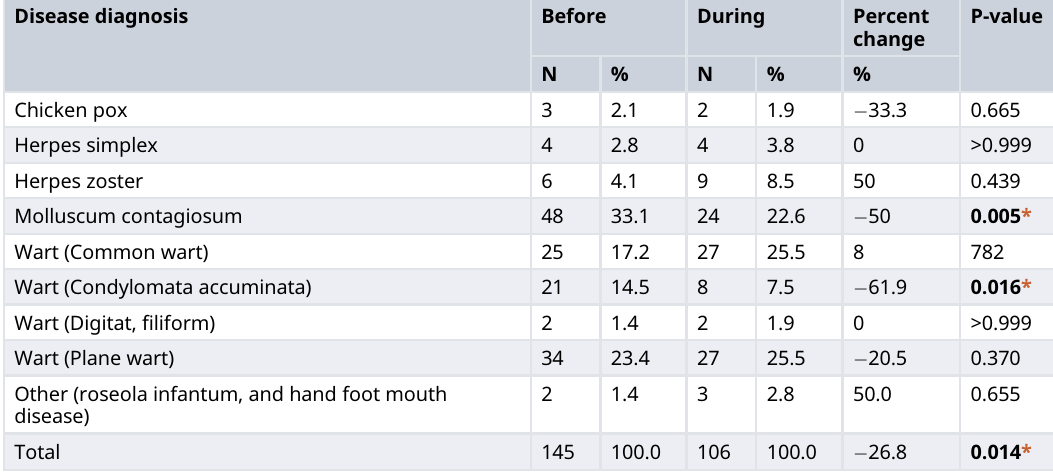
Table 2. The types of cutaneous viral infection before and during coronavirus disease 2019 (COVID-19) pandemic. Disease diagnosis Before During Percent